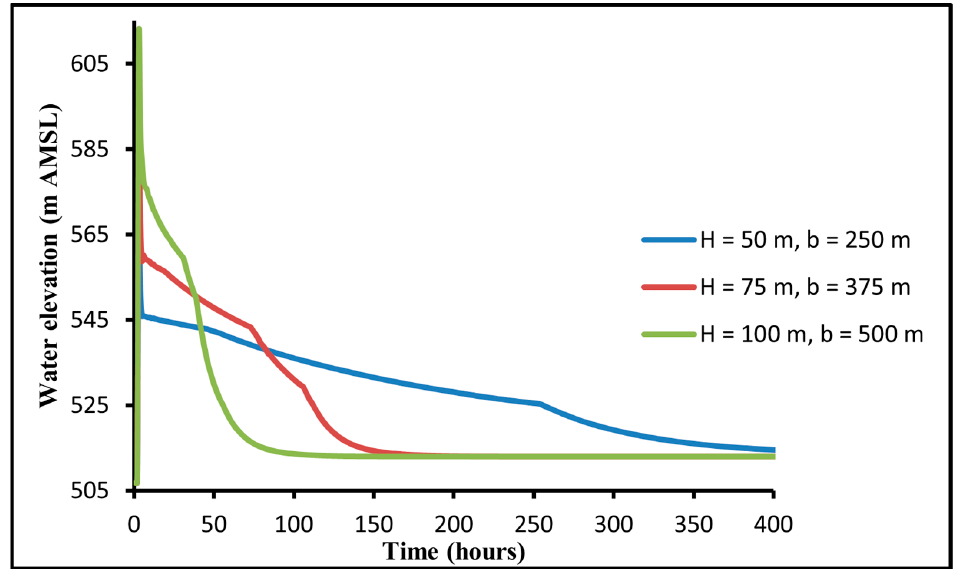
Figure 6. Stage curves due to changes in the breach size.